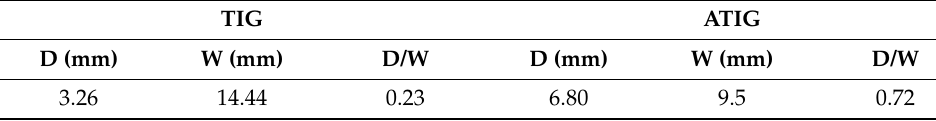
( b ) Figure 10. SEM Micrograph in ATIG fusion zone of 316L ( a ) (250×), ( b ) (500×). In ATIG and TIG weld zone, the ferrite is the result of the incomplete primary delta ferrite- austenite transformation. The proportions of delta ferrite diminish from weld zone to base metal is as shown in Figure 11a,b. In the ATIG heat-affected zone, austenitic grains crossed by parallel elongated in- clined stringers of delta ferrite as shown in Figure 11a. In TIG heat-affected zone, the glob- ular delta ferrite is randomly distributed and in the form of small slats of reduced size in the same rolling direction in a matrix of austenite as shown in Figure 11b.